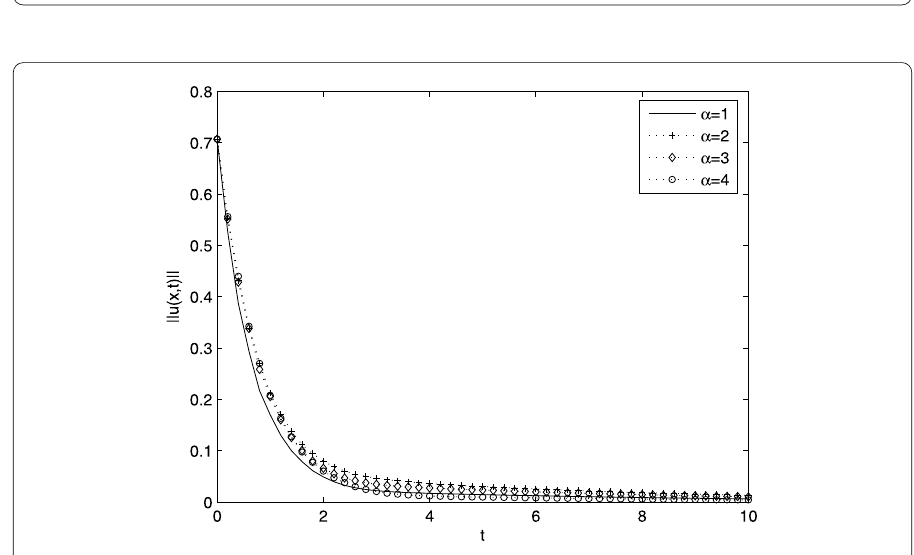
Figure 10 A 3-d landscape of the dynamics of the MGKdVB equation when using the second nonlinear non-adaptive control law; v = 0.01, μ = 0.001, γ 1 = 1, γ 2 = 0.0005 and u 0 ( x ) = sin(2 π x ); ( a ) α = 1; ( b ) α = 2; ( c ) α = 3; ( d ) α = 4